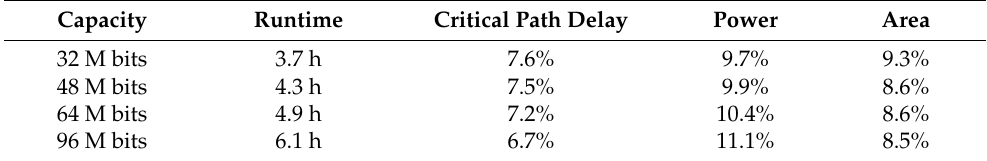
Table 5. The scalability with memory